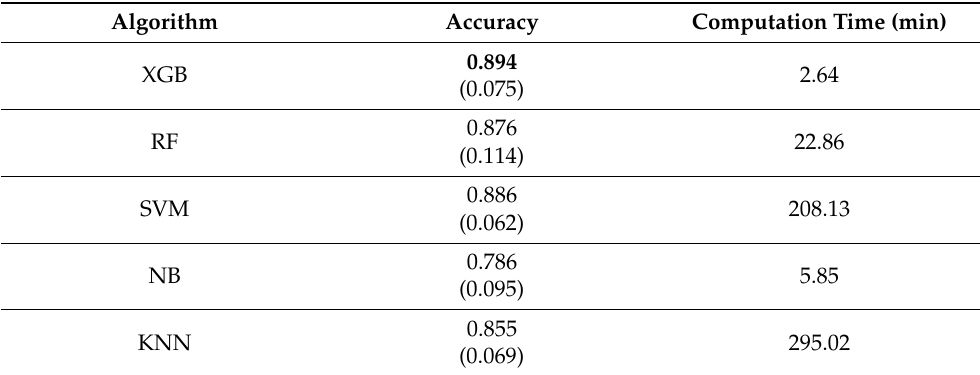
Table 6. Accuracy and computation time for randomly stratified data.